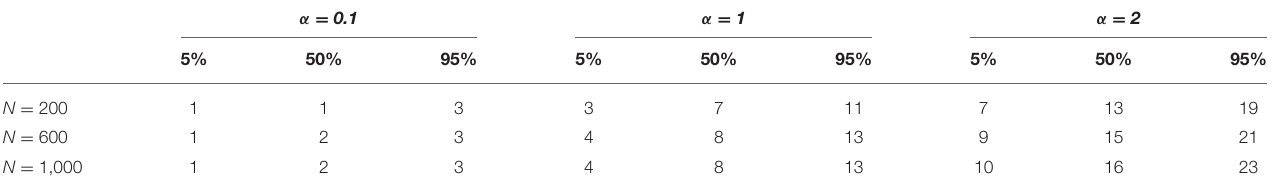
TABLE 1 | Different percentiles (5, 50, 95%) of the distribution of the number of clusters K , given different values of precision parameter α , and sample size N . α =